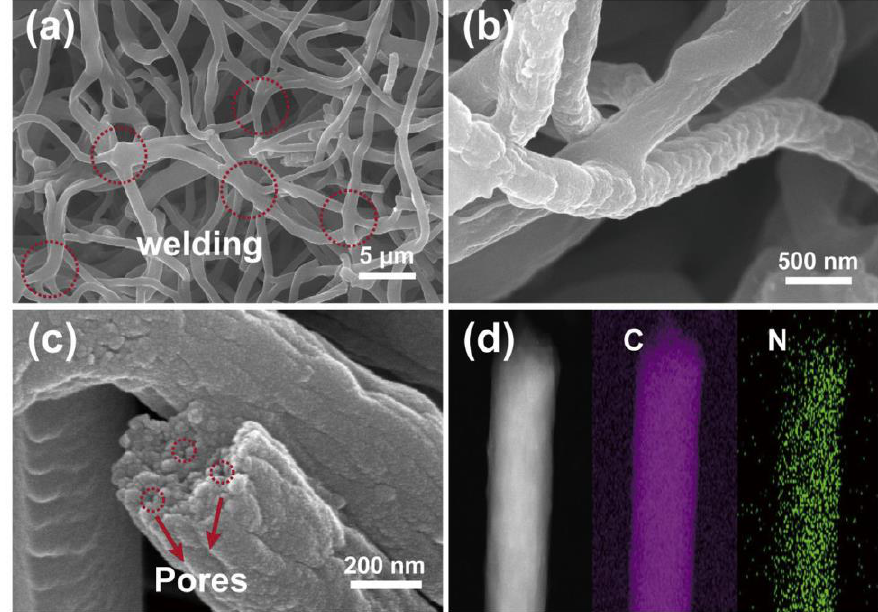
Figure 8. Images and composition of the composite carbon nanofiber aerogel: ( a – c ) SEM images, ( d ) composition. Reprinted with permission from [16]. Copyright © 2019 Elsevier B.V.